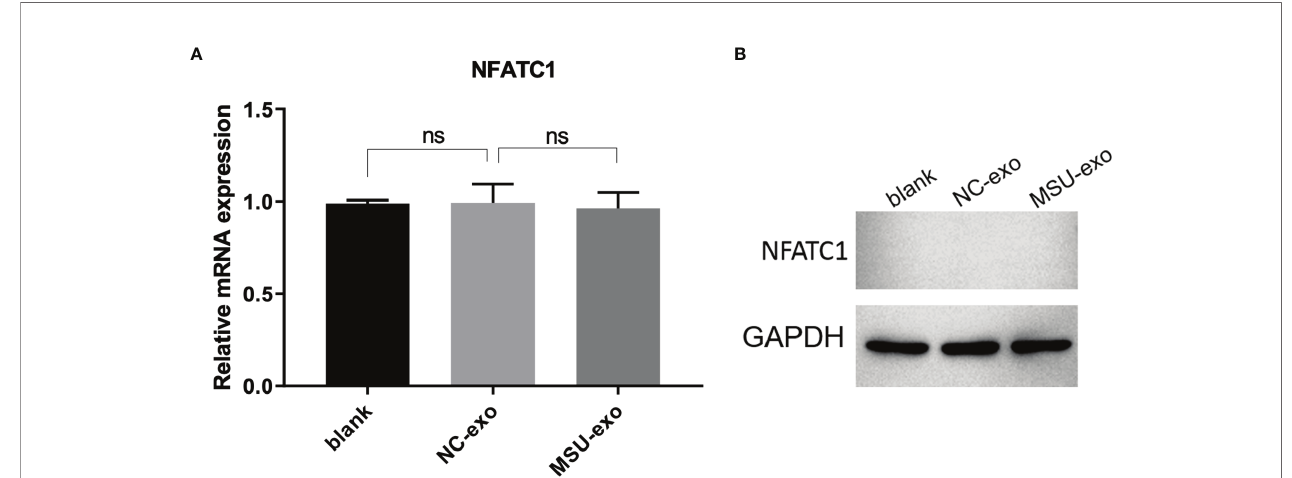
FIGURE 2 | The effects of neutrophil-derived exosomes on osteoclasts. (A) QPCR is used to detect the expression of osteoclastic marker NFATC1, which did not signi fi cantly differ between the two groups. (B) The expression of osteoclastic marker NFATC1 is detected by western blot. There is no signi fi cant differences in the mRNA and protein level of NFATC1. ns, no signi fi cance.